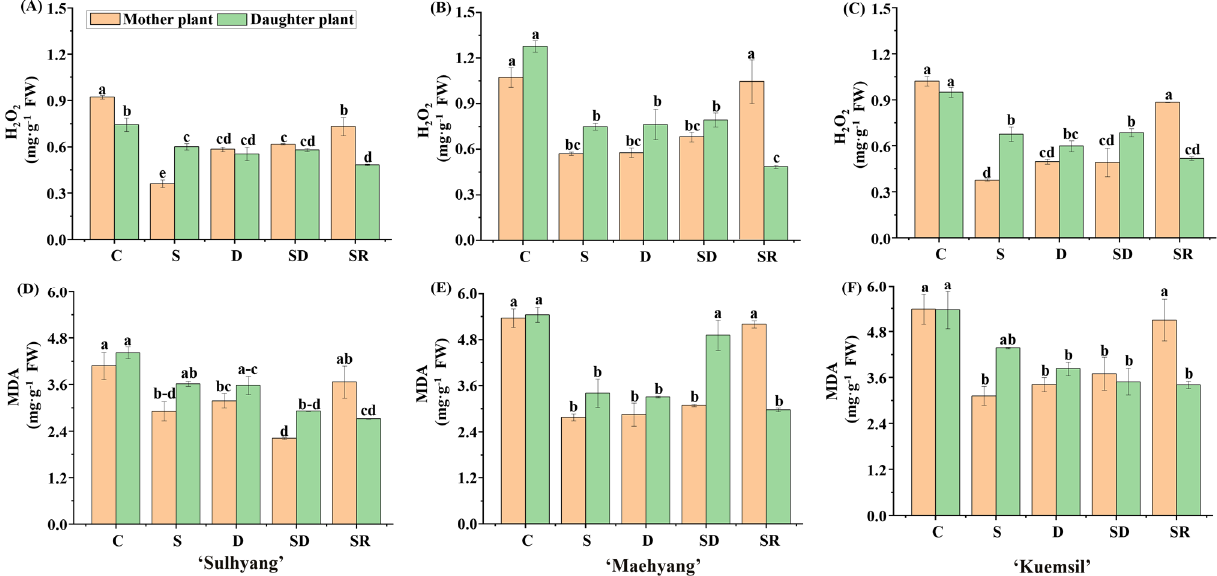
Figure 5. The contents of H 2 O 2 and MDA of strawberry ‘Sulhyang’ ( A , D ); ‘Maehyang’ ( B , E ); and ‘Kuemsil’ ( C , F ) as affected by the Si treatments. Lowercase letters indicate significant differences calculated by the Duncan’s multiple range test at p ≤ 0.05: C, control; S, sprayed “mother” plant; D, drenched “mother” plant; SD, dressed “mother” plant; and SR, sprayed “daughter” plant.